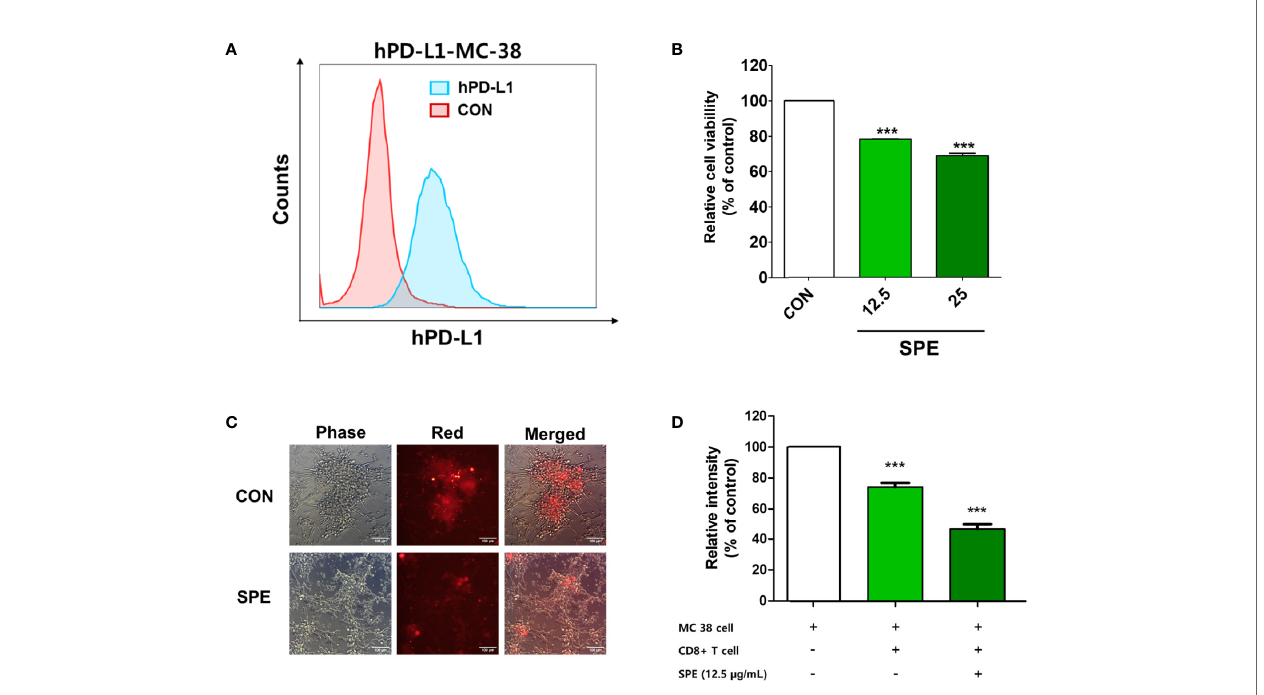
FIGURE 2 | Cytotoxic and T-cell-mediated killing effect of SPE on colorectal cancer cells. (A) PD-L1 expression on the surface of humanized PD-L1-expressing MC38 cells (hPDL1-MCs) was determined using fl ow cytometry. (B – D) To measure the immunological activity of SPE, hPDL1-MCs (target cells) were co-cultured with humanized PD-1 mouse splenocytes (B, C) and CD8+ T-cells from the tumor (D) (hPD1-MSs; effector cells) at an effector cell-to-target cell ratio of 5:1 and were treated with SPE or 50% DMSO (control). (B) After 72 h of incubation, surviving hPD1-MSs in a 96-well plate underwent the CCK assay to assess cell viability. (C) Co-cultured CellTrace ™ Far Red-labeled hPDL1-MCs were treated with SPE (25 m g/mL) or 50% DMSO (control), and the fi ndings were compared with those in the absence of effector cells. The images were obtained under a fl uorescence microscope. (D) The cytotoxicity of CD8+ T-cells against hPD-L1-MCs at an effector cell-to-target cell ratio of 5:1 was analyzed using an LDH assay kit (percentages calculated according to kit instruction). ***P < 0.001, compared with the